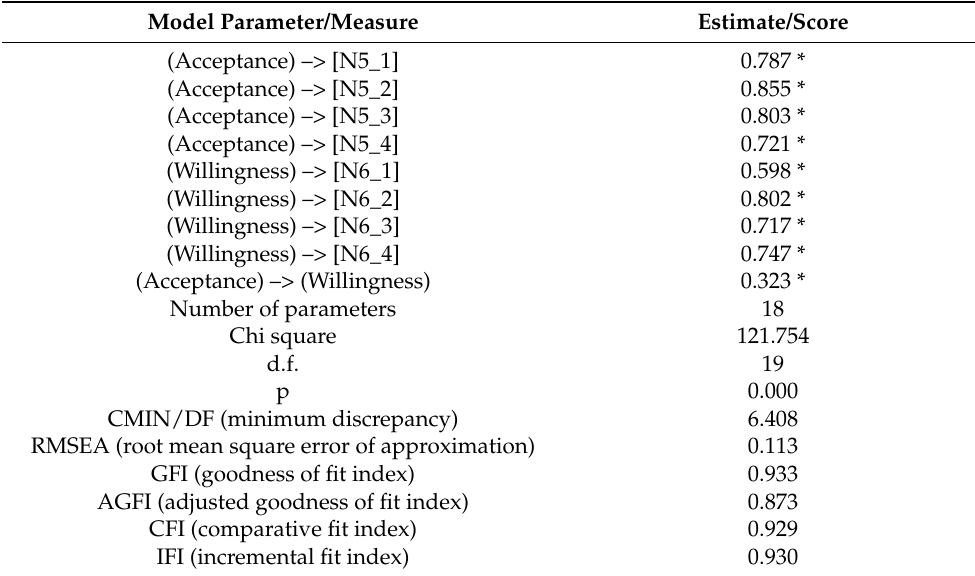
Table 9. Summary of structural equation model between perceived acceptance of PwD and willing- ness to employ